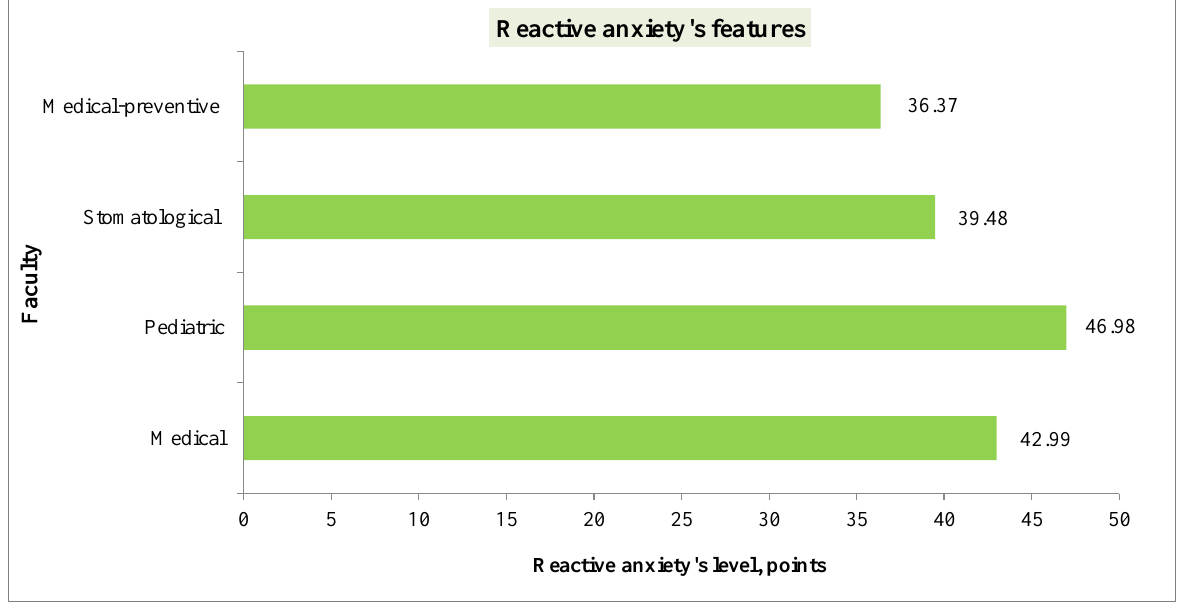
Figure 3. The reactive anxiety's level of medical students depending on the faculty program specifics. Comparison of the students' psychological state of the medical faculty of a regional medical university (V.I. Razumovsky SSMU) and a megalopolis university (Sechenov University), studying in a distance format (Figure 2), revealed the absence of significant differences between the level of their reactive anxiety (42.99 ± 1.97 and 44.29 ± 1.81, respectively).